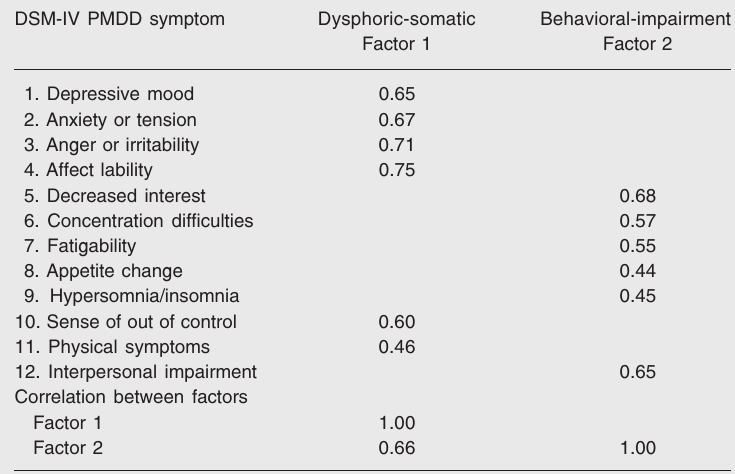
Table 4. Parameter estimates from the results of confirmatory factor analysis